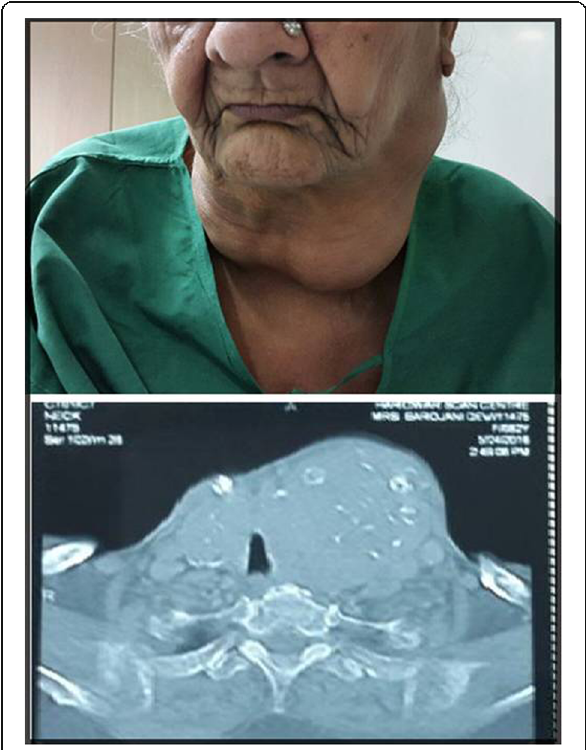
Fig. 1 Preoperative image of massive carcinoma thyroid in